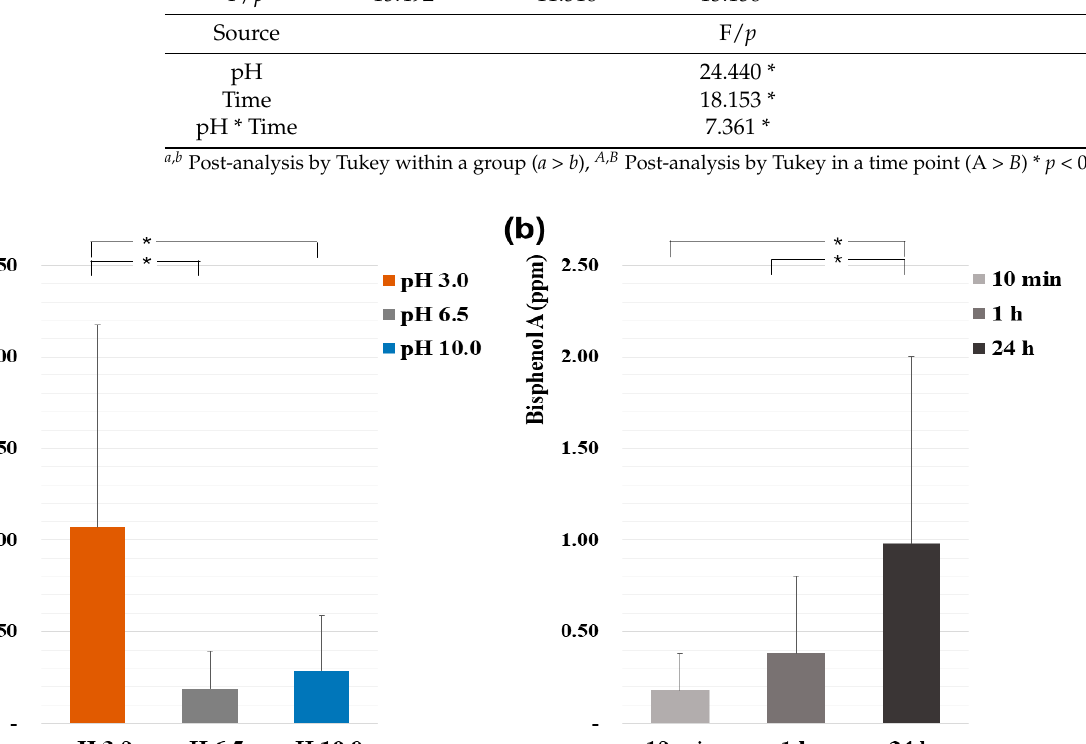
Table 6. BPA concentration (ppm) according to pH levels and time of each sealant.